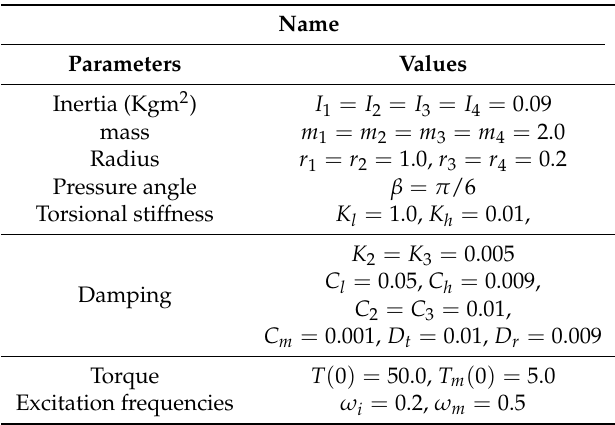
Table 1. Table of parameters for Figures 5 and 6.